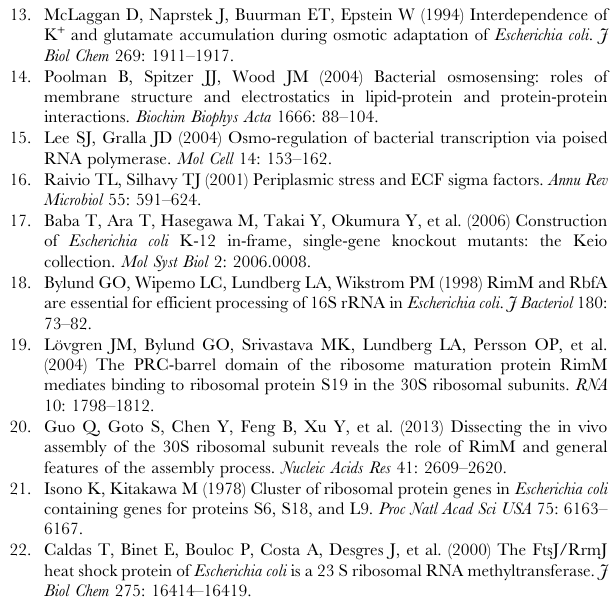
Figure S1 Accumulation of 17S RNA in D rsgA , D rbfA , D rimM , D rpsF or D rrmJ cells. One mg of total RNA was subjected to electrophoresis on denaturing MOPS-formaldehyde 1.8% agarose gel. The band of slightly lower migration than that of 16S rRNA was confirmed as 17S RNA by northern hybridization using 3 9 -DIG labeled probe 9 and probe 12, which are complimentary to 16S rRNA and its 5 9 extension, respectively (Hase et al ., 2009). Figure S2 Effects of depletion of a maturation factor or a ribosomal protein S6 and addition of protein synthesis inhibitor on subunit association of the ribosome. Cells depleted of a maturation factor or S6 were grown at 37 u C in LB medium, and wild type cells were grown at 37 u C in LB medium supplemented with 80 m g/ml kasugamycin or 1.2 m g/ml chlor- amphenicol. When OD 600 reached 0.8, 0.9 M NaCl was added to the medium. Cells, which were collected at 0, 4 and 8 hours after salt shock, were lysed with alumina powder and the cell debris was removed as described in Materials and Methods. Crude cell extracts were fractionated by 5%–20% sucrose density gradient ultracentrifugation. Peak height of each subunit relative to that of 70S ribosome is shown above the peak. Figure S3 Effect of salt shock on cell growth of D ksgA or D lonA . (A) Growth of wild-type, D rsgA , D ksgA or D lonA cells at 37 u C in LB medium was monitored by measuring OD 600 . (B) Cells were grown at 37 u C in LB medium. When OD 600 had reached 0.8, 0.9 M NaCl was added to the medium. The OD 600 value subtracted from that measured immediately after salt shock is plotted. (C) Accumulation of 17S RNA in D ksgA and D lonA cells.